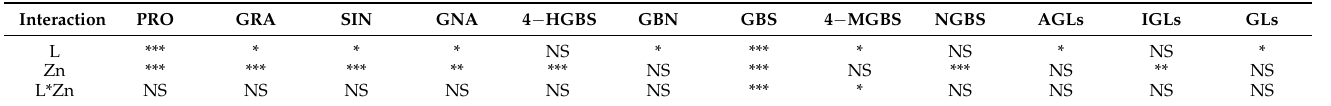
Table 6. The interaction effects of individual glucosinolate contents and total glucosinolate content in flowering Chinese cabbage sprouts (FCCS).